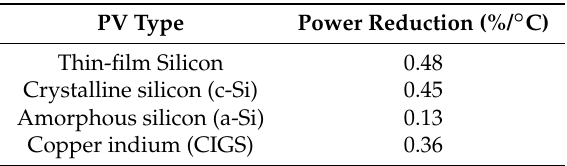
Table 6. The rate of power reduction in PV panels due to temperature